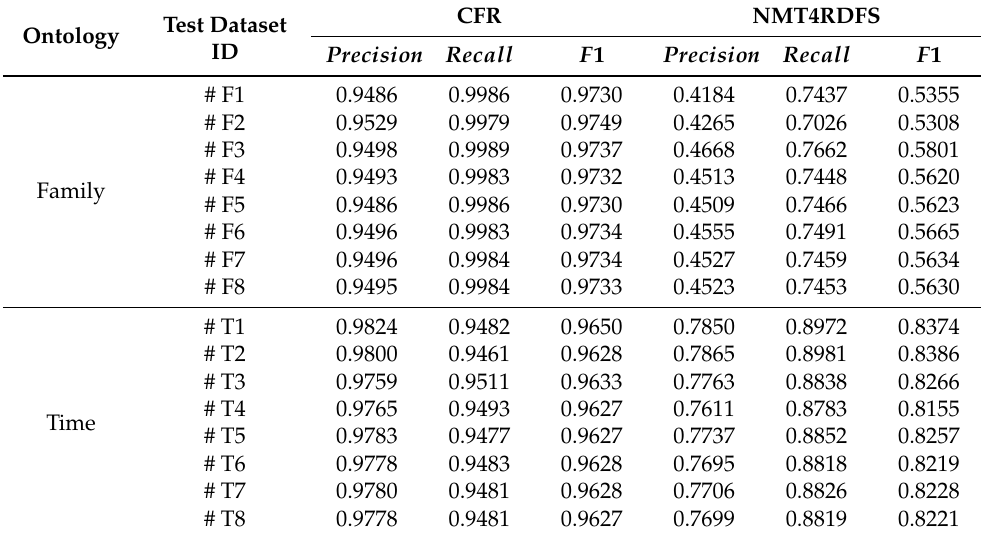
Table 6. The precision , recall and F 1 of all assertions (A) of the CFR and NMT4RDFS on independent synthetic test